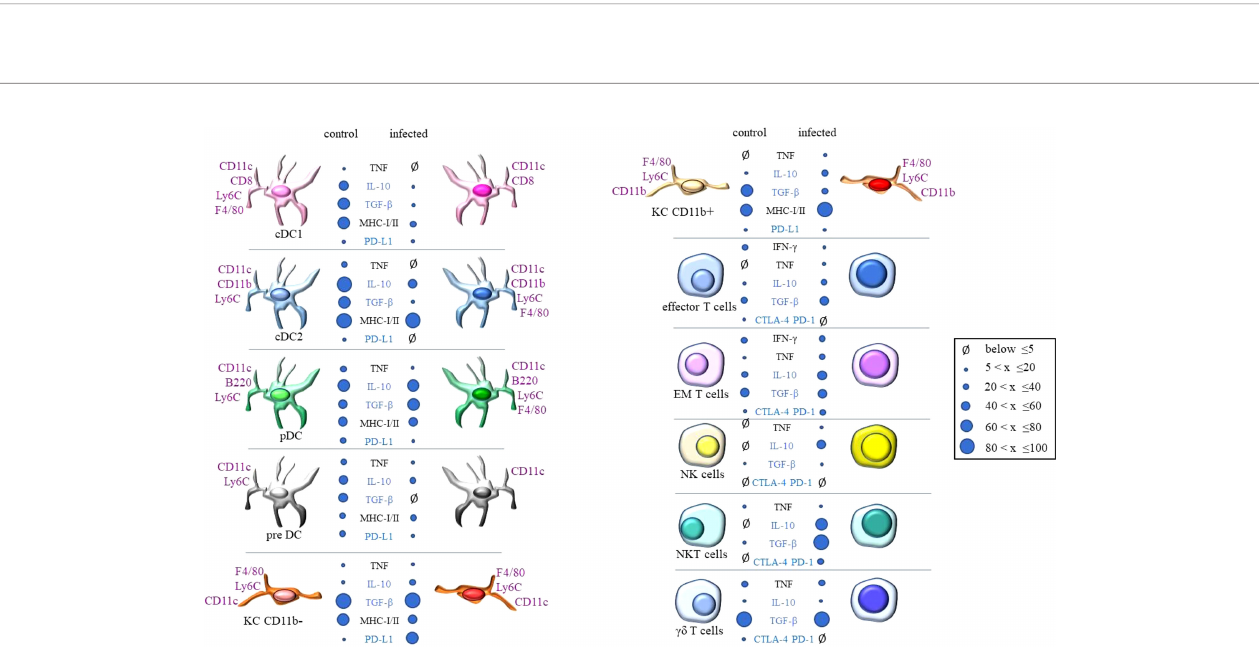
FIGURE 9 | Production of anti- and pro-in fl ammatory cytokines by NK, NKT, and gd T lymphocytes. The intrahepatic cells were isolated from control and T. cruzi infected mice on dpi 15, and the production of TNF- a , IL-10, or TGF- b 1 was analyzed in NK (A) , NKT (B) , and gd T lymphocytes (C) . * means p ≤ 0.05, **** means p ≤ 0.001 using the Kruskal Wallis test followed by the Dunn ’ s post-test.